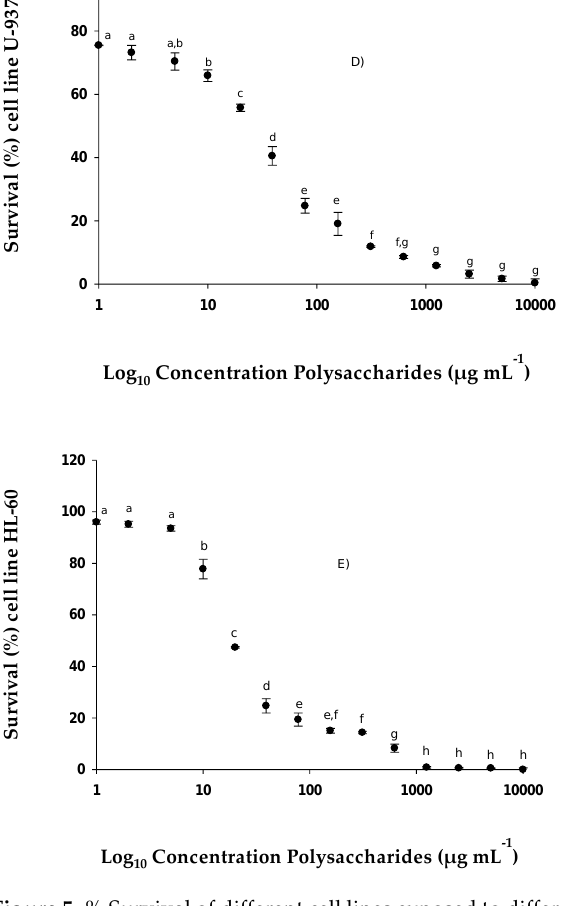
Figure 5. % Survival of different cell lines exposed to different concentrations of polysaccharides from E. gracilis : ( A ) % Survival of cell line HTC-116; ( B ) % Survival of cell line NCl-H460; ( C ) % Survival of cell line MCF-7; ( D ) % Survival of cell line U-937; ( E ) % Survival of cell line HL-60. Similar letters indicate that there are no significant differences (Tukey, p < 0.05) between the different concentrations.